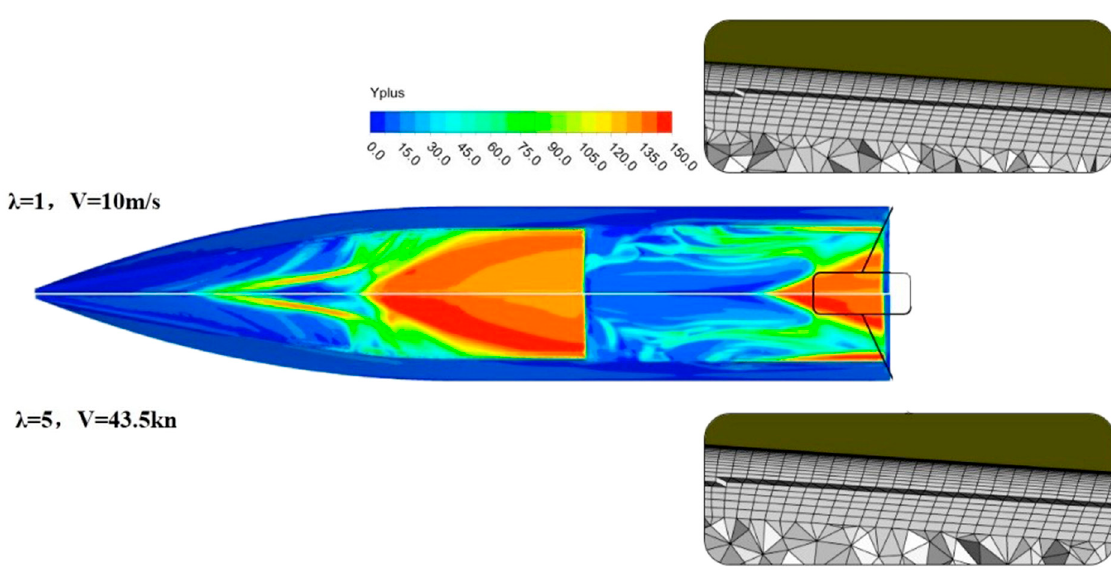
Figure 7. Y+ distribution and boundary layer mesh in both model and real scale.